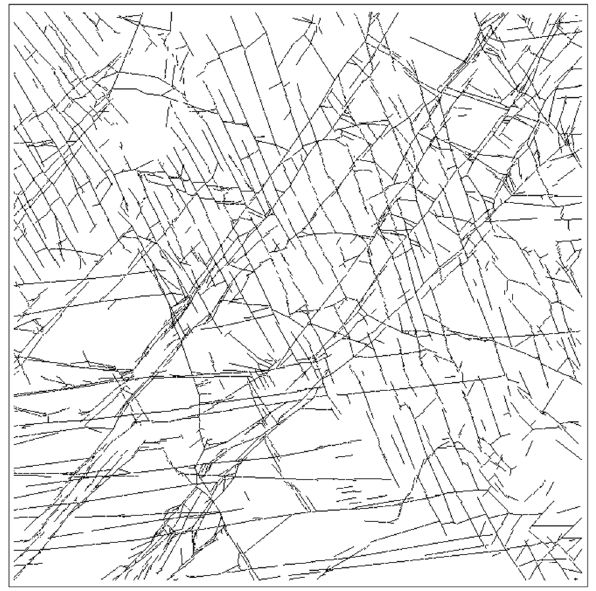
Fig. 2 Planview of 18 × 18 m Hornelen fracture pattern in the Devo- nian sandstones of western Norway (Odling et al.